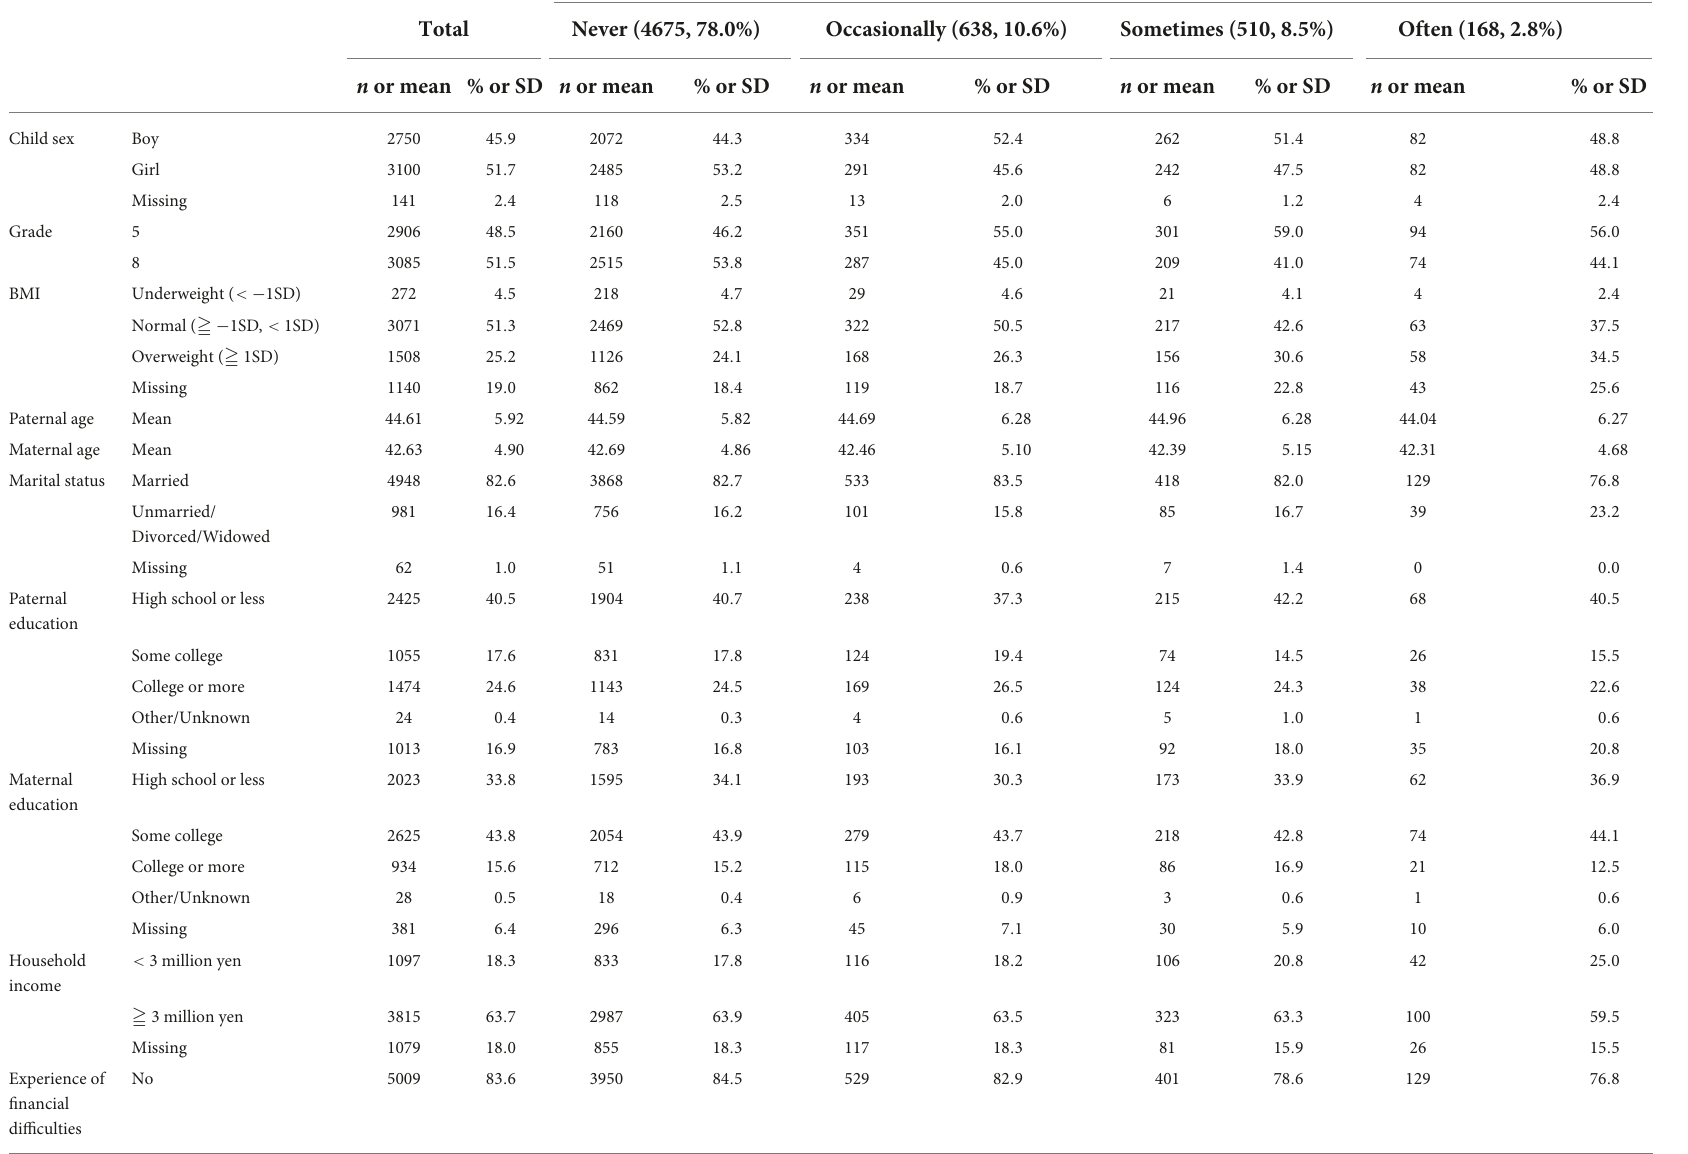
TABLE 1 Descriptive characteristics of study